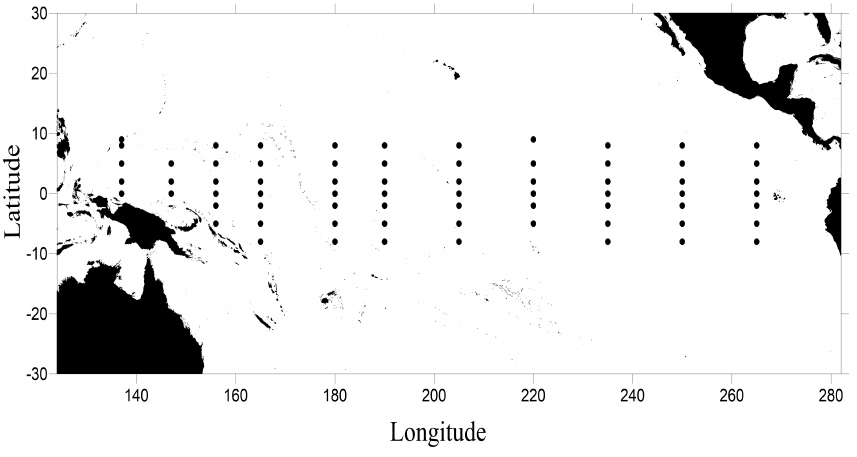
Figure 6. Location of measurement data from NOAA/PMEL TAO buoy network.